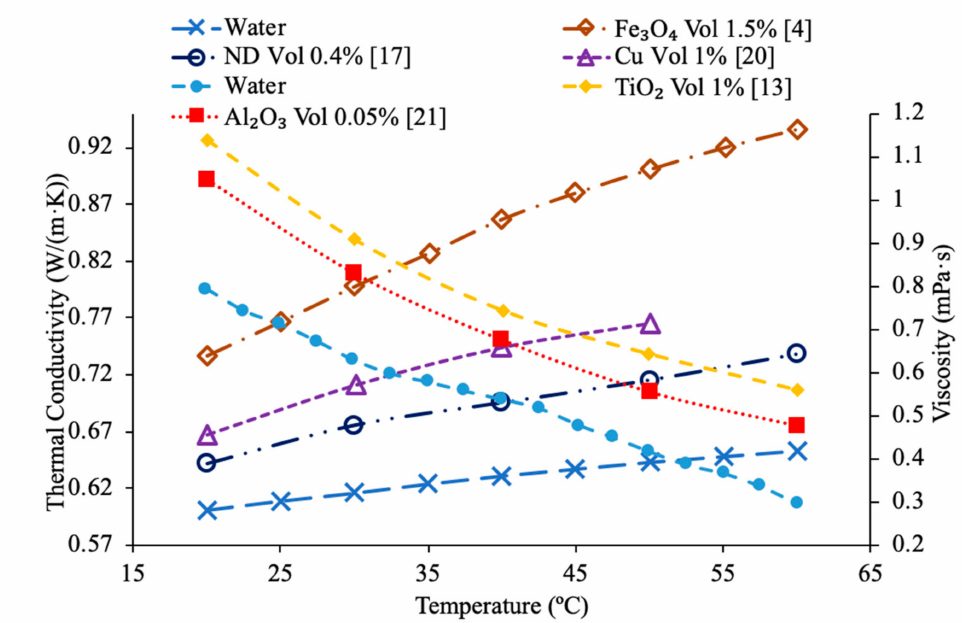
Figure 3. Thermal conductivity (increasing with temperature) and viscosity (decreasing with temper- ature) for various water-based nanofluids at various volume fractions